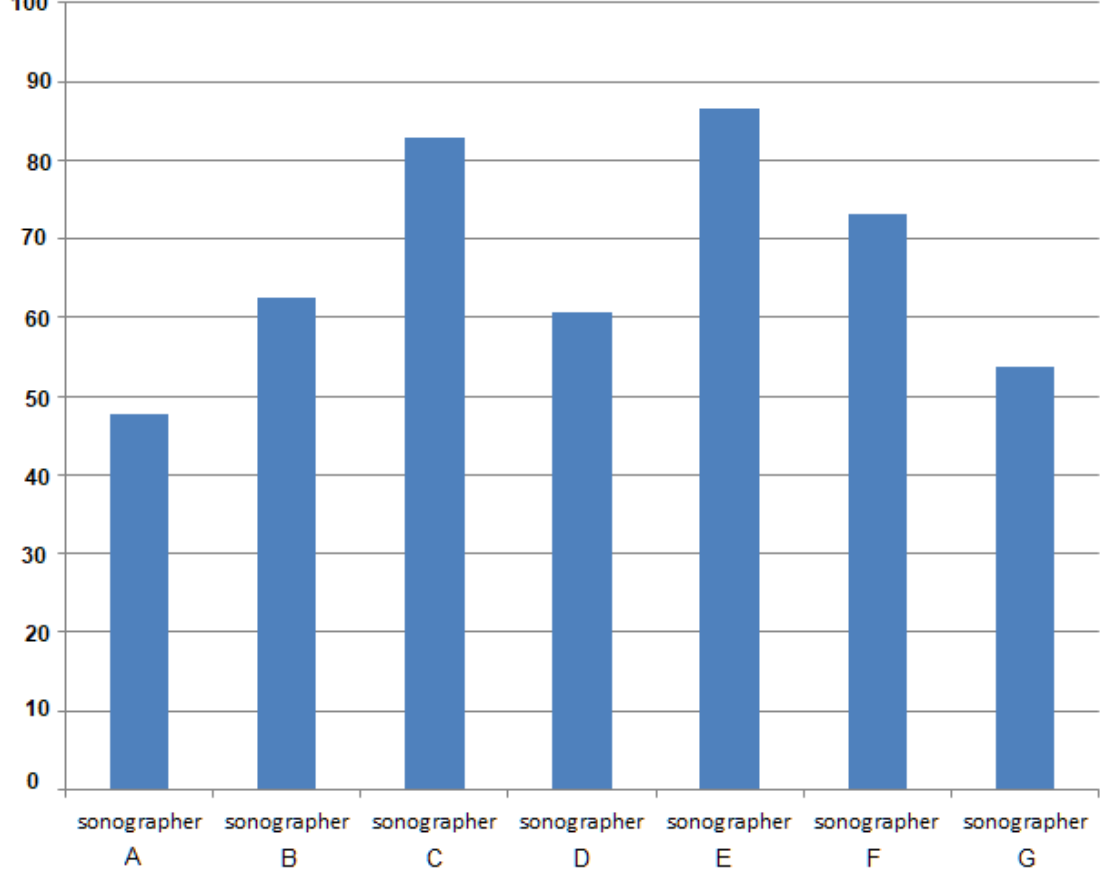
Figure 4. Variation in cVR-Both by individual sonographers as calculated by the random effects bivariate probit